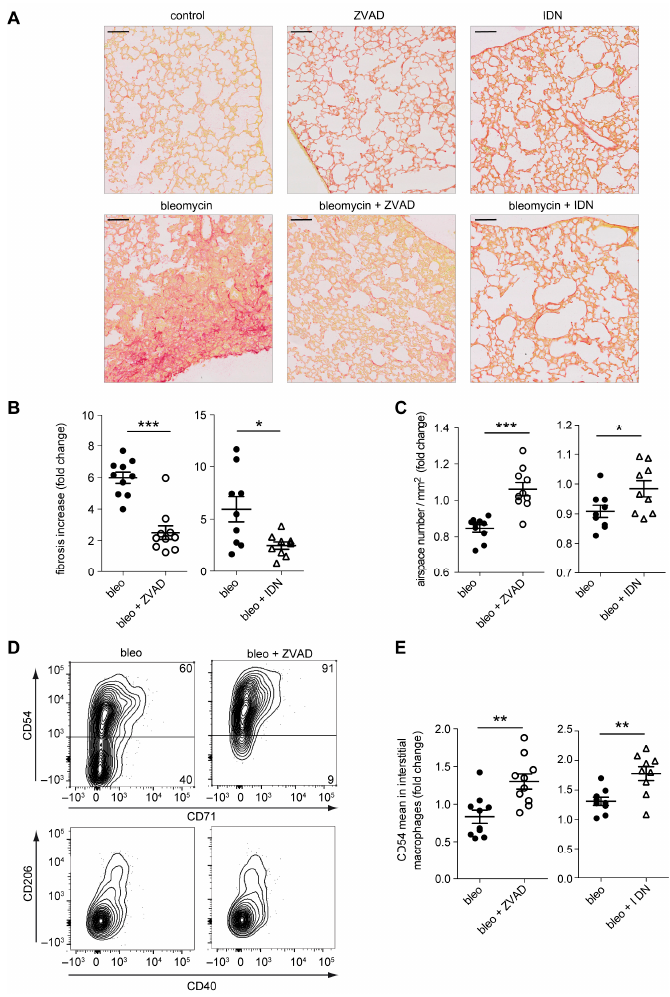
Figure 9. Emricasan prevents bleomycin-induced lung fibrosis. ( A ) Representative histological pictures of Sirius Red-stained lung tissue sections from untreated mice (control) and mice injected intraperitoneally with bleomycin sulphate (0.1 mg/g body weight) once a week for 3 weeks, without (bleomycin) or with Z-VAD-FMK (bleomycin + ZVAD, 1 µg/g body weight intra-peritoneally every day for three weeks) or Emricasan (bleomycin + IDN, 18 µg/g body weight subcutaneously twice a day during three weeks) and mice treated with Z-VAD-FMK (ZVAD) or Emricasan (IDN) alone. Lungs were fixed in FineFix and paraffin embedded before staining collagen fibers with Sirius Red. Scale bar, 100 µm. ( B ) Quantification of Sirius Red labeling intensity. Results are expressed as fold change in Sirius Red staining in treated compared to control mice (bleomycin was compared to un- treated, bleomycin + ZVAD to ZVAD alone, bleomycin + IDN to IDN alone). Each dot or square is an individual mouse. ***, p < 0.001; *, p < 0.05; Mann–Whitney test. Mean ± SE. ( C ) Quantification of